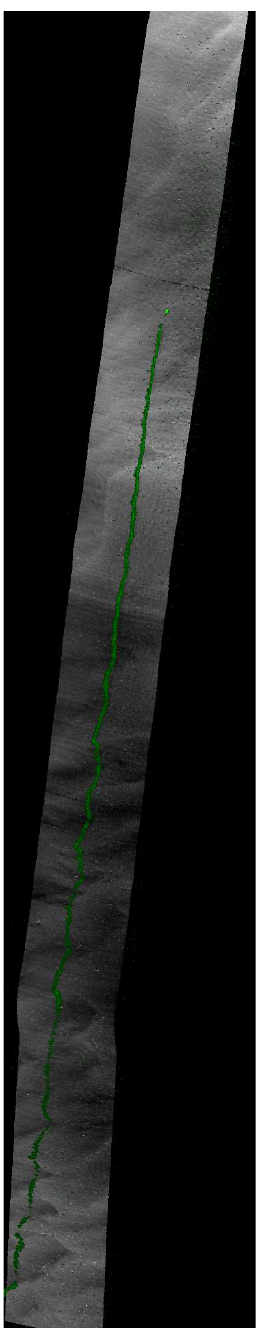
Figure 7. A raw infrared swath (greyscale) overlaid with a visible image of the Uranine dye plume (green). See Section 3.2 for dimensions and temperature color bar definitions.